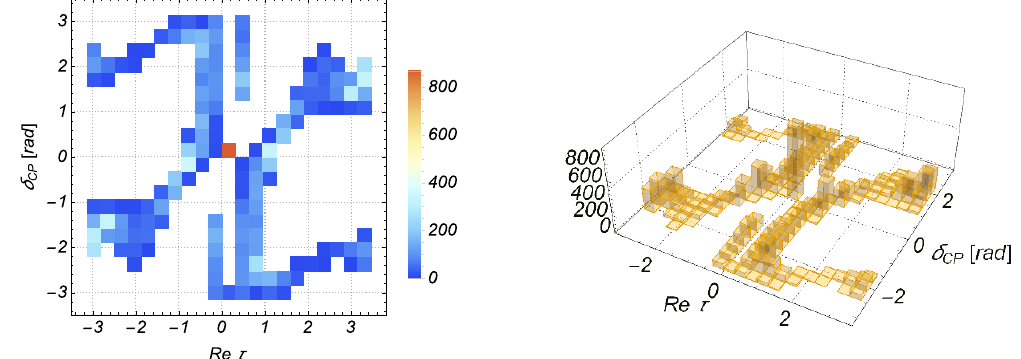
Figure 5 . Distributions of the CP-violating phase δ CP vs. real part of complex structure modulus Re τ for Im τ = 2 . 0 in Pattern